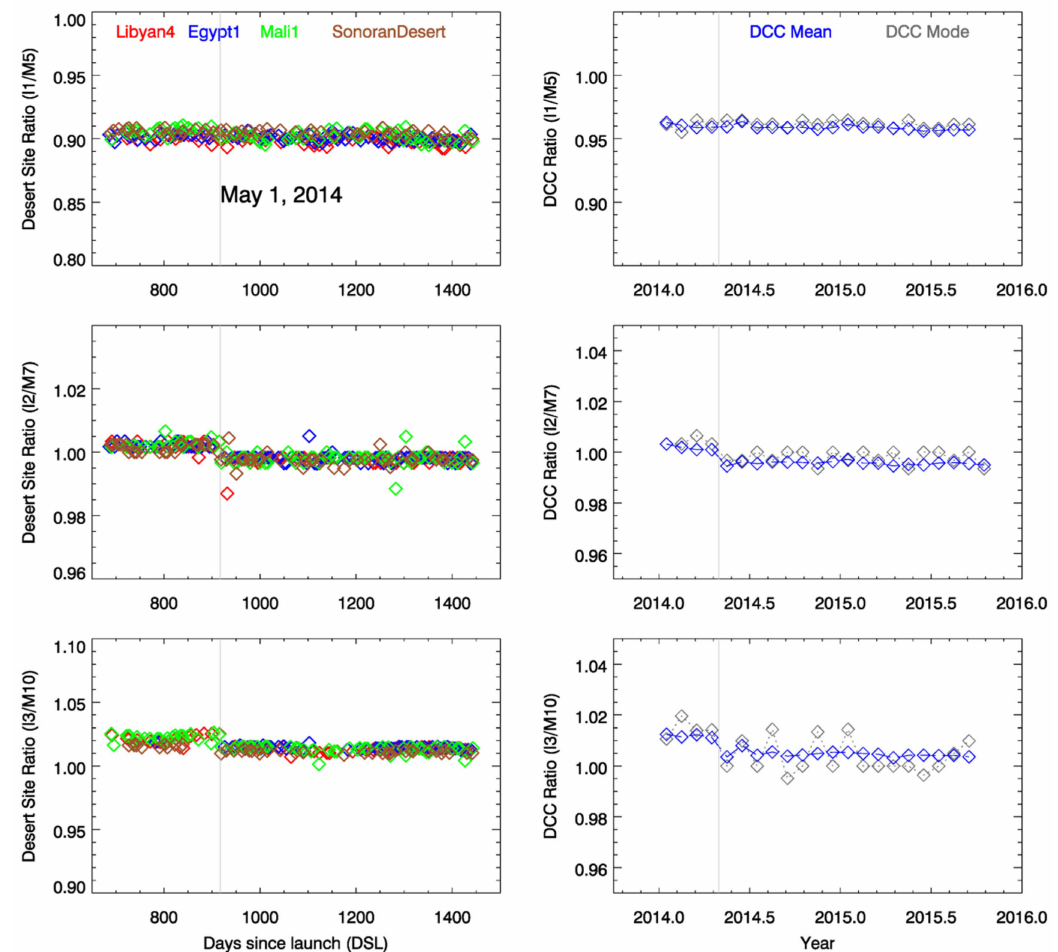
Figure 14. Comparison of DCC mean band ratio and validation site band ratio time series for I1/M5, I2/M7 and M10/I3. The vertical lines in the plots mark 1 May